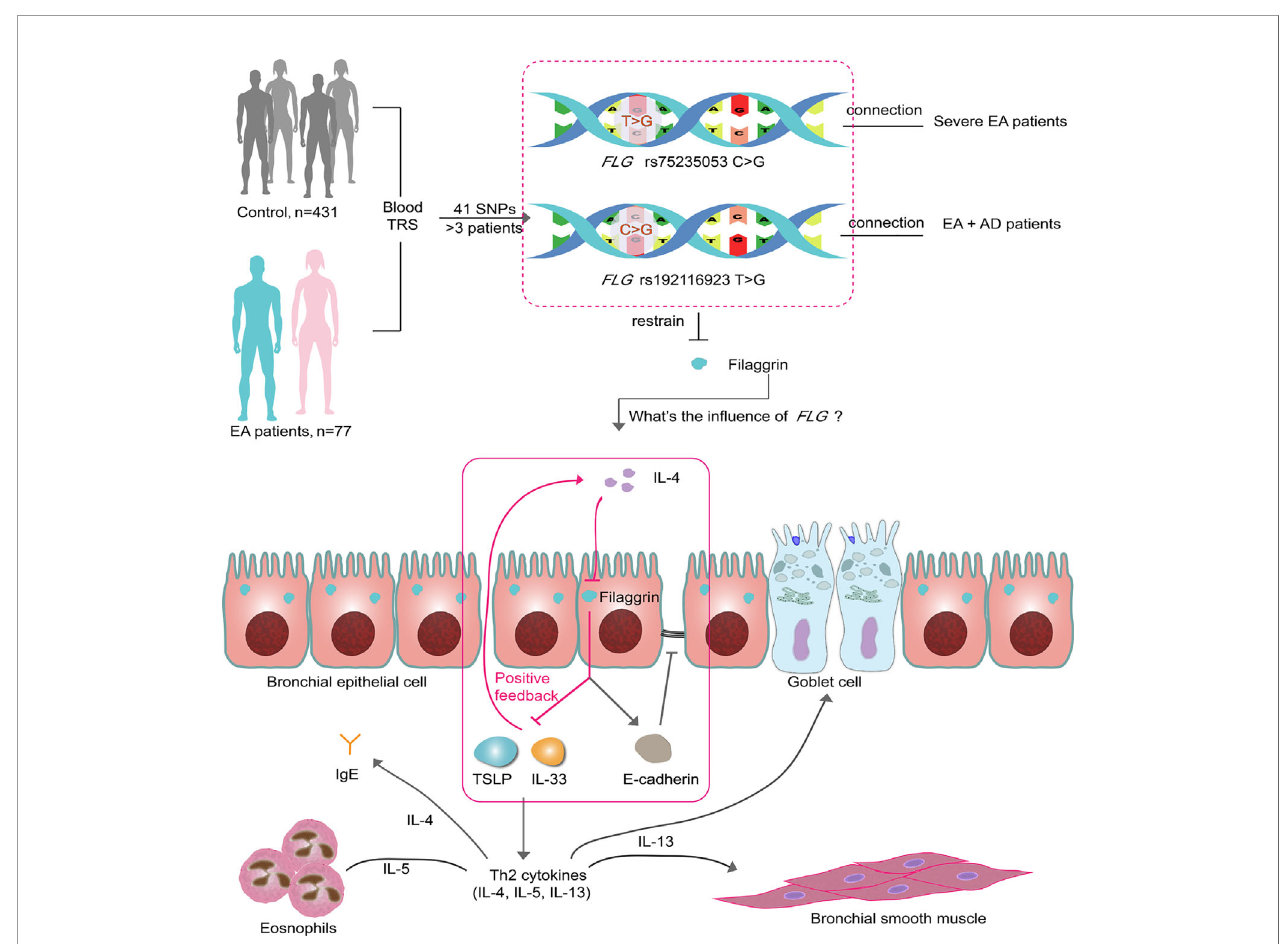
FIGURE 9 | Two SNPs may in fl uence EA patients via fi laggrin through a positive feedback mechanism. There are 41 SNPs indenti fi ed from 77 EA patients by TRS. Two of them in FLG gene are associated with the clinical characteristics of EA patients. In this article, it has been proven that fi laggrin expression is inhibited by the Th2 cytokine IL-4 in human bronchial epithelial cells, while the reductive fi laggrin increases the expression of epithelial derived cytokines TSLP and IL-33 which induce the releasing of Th2 cytokines such as IL-4 and form a positive feedback loop (red box). The declining fi laggrin also intensi fi es the reduction of E-cadherin induced by IL-4. EA, Eosinophilic asthma; AD, atopic dermatitis; TRS, target region